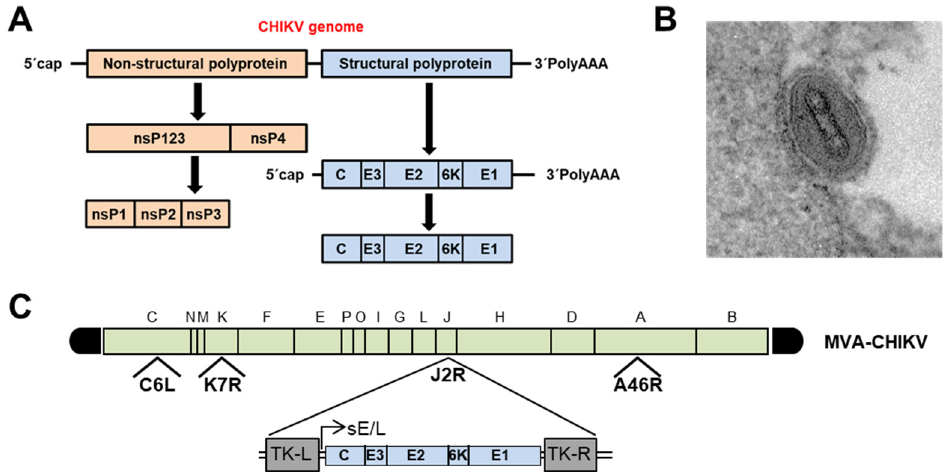
Figure 1. CHIKV genome organization and MVA-CHIKV vaccine candidate. ( A ) CHIKV genome. CHIKV has a single-stranded, positive-sense RNA genome of approximately 11.8 kb in length. It has 2 open reading frames (ORFs) separated by an untranslated junction region. One ORF encodes for a polyprotein, which is the precursor of the nonstructural proteins nsP1, nsP2, nsP3 and nsP4. The second ORF encodes the structural proteins capsid ( C ), envelope 1 (E1) and envelope 2 (E2) and 2 small peptides, E3 and 6K. The genome has 5 ′ cap structures and a 3 ′ poly A tail. ( B ) Electron microscopy image of an MVA virus particle bound to the cell membrane, produced at 12 hpi in primary chicken embryo fibroblast cells, following methods described previously (scale bar 50 nm) [36]. ( C ) MVA-CHIKV vaccine candidate. The different HindIII restriction fragments of the MVA genome are indicated by green boxes and in capital letters, as described [37], with the left and right terminal regions shown in black. Deletions of genes C6L, K7R and A46R in the MVA-CHIKV genome are also indicated. The CHIKV structural genes C, E3, E2, 6K and E1 driven by the strong synthetic early/late (sE/L) virus promoter [38] inserted within the VACV TK viral locus (J2R) are indicated [39].